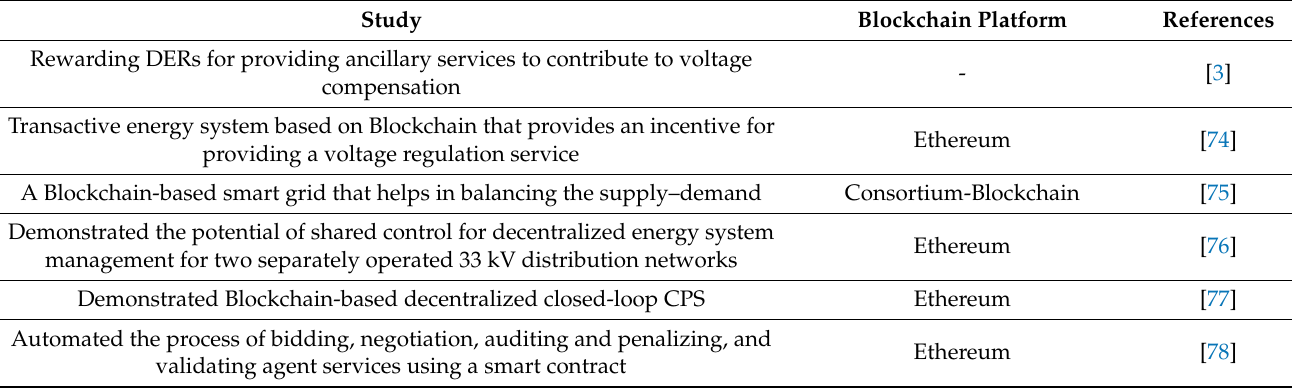
Table 7. Summary of publications employing Blockchain technology for grid